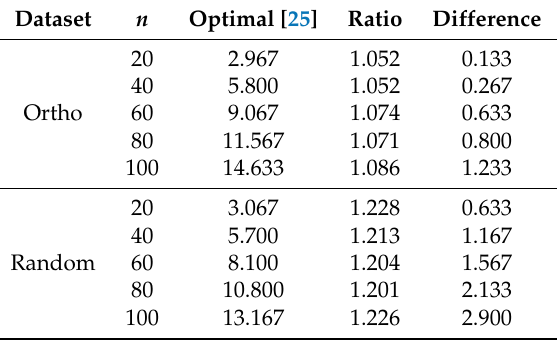
Table 8. Comparison with the optimal